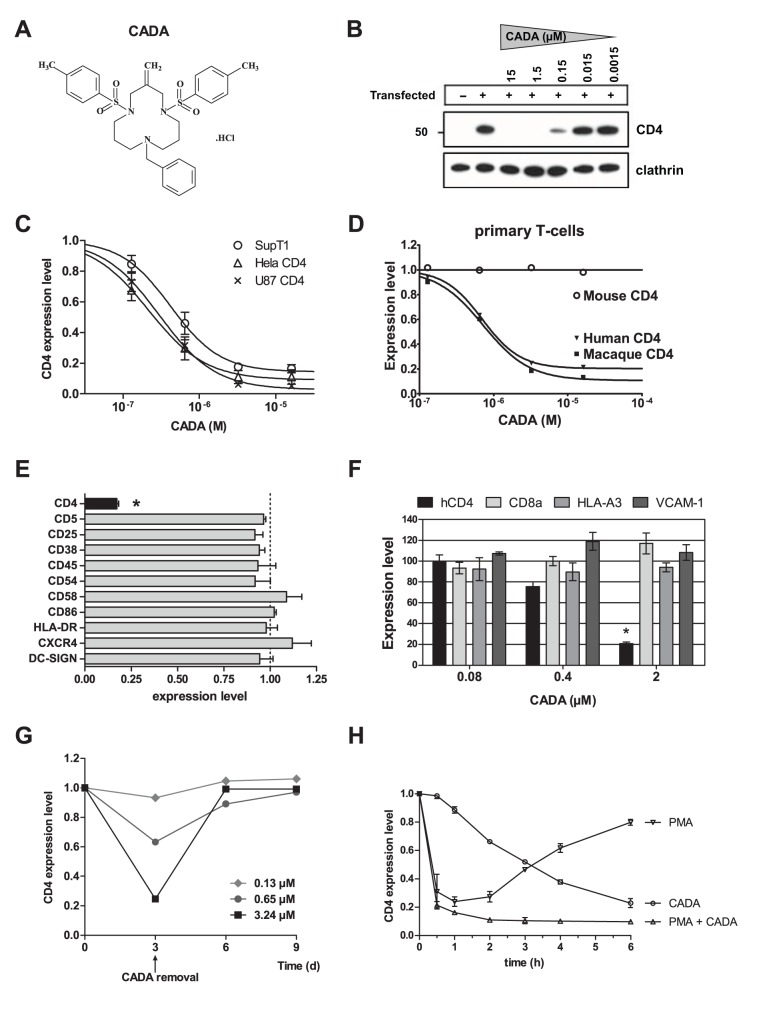
CADA selectively and reversibly down-modulates human CD4 in a dose-dependent way.(A) Structure of CADA, molecular weight (MW) = 618. (B) U87 cells stably expressing hCD4 were treated with a serial 1∶10 dilution of CADA. After 24 h, cell lysates were analyzed by immunoblotting with anti-CD4 or anti-clathrin antibodies. A non-transfected control is included (first lane). Molecular mass is in kDa. (C) Dose-response curve showing the effect of CADA on hCD4 expression in the human T-lymphoid cell line SupT1 expressing CD4 naturally (circles; IC50 is 0.55 µM), in the stably transfected human U87 glioblastoma (crosses, IC50 is 0.32 µM) and Hela epithelial cervical cancer cells (triangles, IC50 is 0.27 µM). Surface CD4 expression levels were normalized to non-treated controls as determined by flow cytometry (n≥4). (D) Dose-response curve showing the selective effect of CADA on primate CD4. Primary T-cells isolated from the blood of humans, macaques, or mice were stimulated with 2 µg/ml phytohaemagglutinin (PHA) and treated with CADA for 3 days. Next, cells were stained for surface CD4 and analyzed by flow cytometry. Data represent mean values from two different donors. (E) Human T-lymphoid MT-4 cells were treated with control medium or 3.2 µM CADA. After 24 h, cell surface proteins were quantified by flow cytometry. DC-SIGN expression was determined in stably DC-SIGN-transfected CEM cells. Protein expression levels were normalized to non-treated controls (three independent experiments of 10,000 analyzed cells each). *p<0.01. (F) Flow cytometry analysis of surface proteins in transfected HEK293T cells treated with CADA for 48 h. Protein expression levels were normalized to non-treated controls (three independent experiments). *p<0.01. (G) CD4 down-modulation by CADA is reversible. Primary human T-cells isolated from the blood of healthy donors were stimulated with 2 µg/ml PHA and treated with CADA for 3 days. Next, cells were washed and given control medium for another 6 days. Cells were harvested at specified time points and analyzed for surface CD4 expression by flow cytometry. Data represent mean values from two different donors. (H) Kinetics of CD4 down-modulation showing a slow but steady removal of surface CD4 with CADA, and a fast but transient decrease in CD4 with PMA. Graph represents flow cytometric surface CD4 analysis of CHO cells stably expressing hCD4 either treated with 16 µM CADA or 0.16 µM PMA, or treated simultaneously with CADA and PMA. Surface CD4 expression levels were normalized to non-treated controls (n≥2).